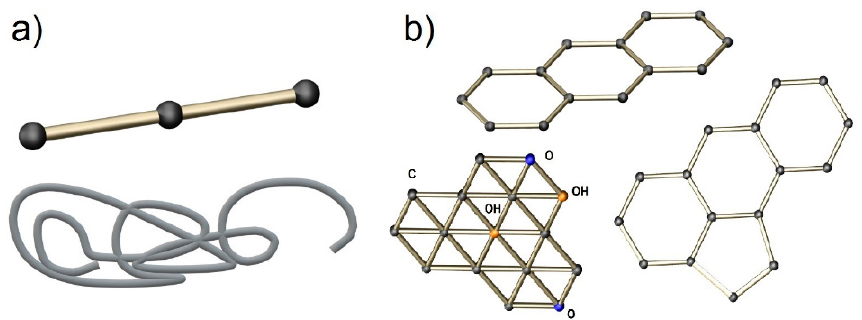
Figure 4. Selected basic structural characteristics of polymers after synthesis—( a ) linear polymer chain, ( b ) branch polymer network structures. Table 1. Mechanical properties of selected materials used in medical applications (adapted from [8–12]).